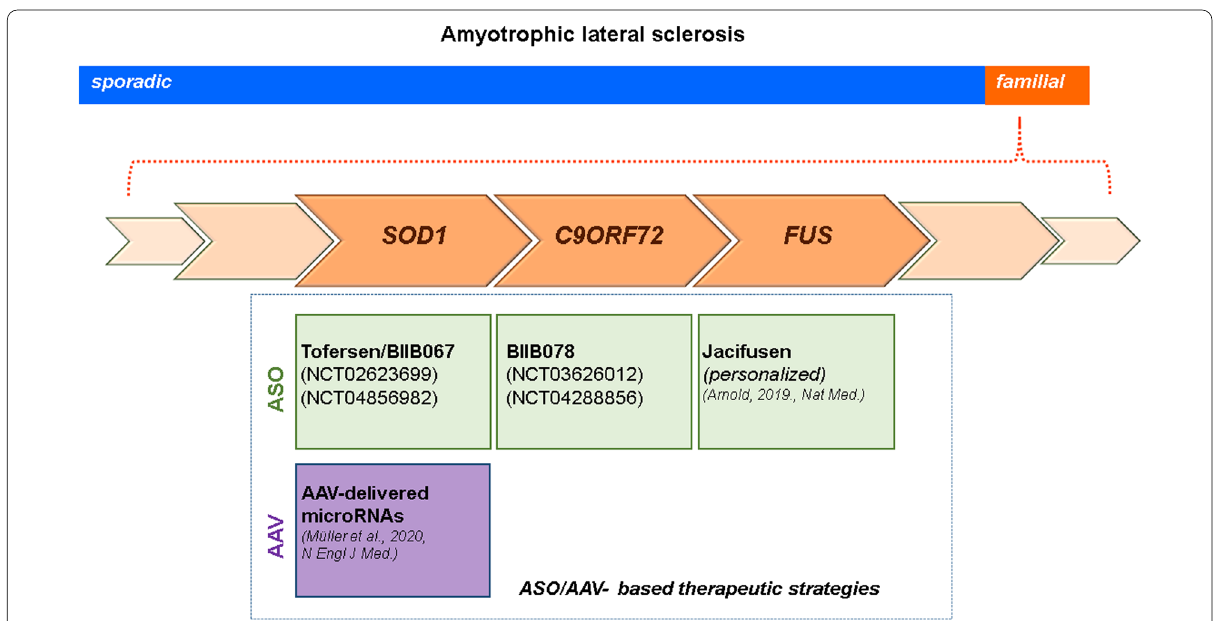
Fig. 4 Different therapeutic strategies in familial forms of amyotrophic lateral sclerosis. Illustration of the different ASO and AAV approaches for the SOD1-, C9ORF72-, and FUS-ALS